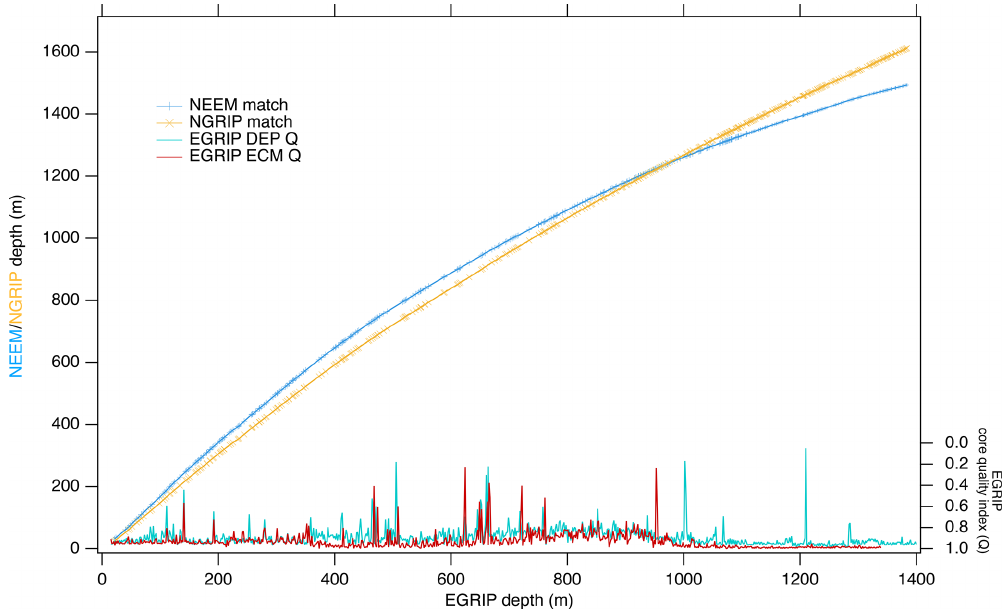
Figure 3. Match points between EGRIP, NEEM (blue) and NGRIP (yellow) ice cores based on the DEP and ECM data sets. The core quality index Q is derived from the validated DEP (blue) and ECM (red) data,